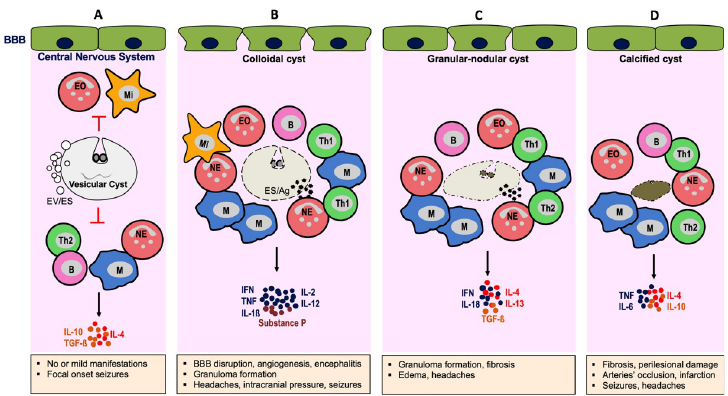
Fig 2. Cyst involution in brain parenchyma and associated immunopathogenesis. The presence of viable vesicular cysts (A) is usually asymptomatic and associated with suppression of the host immune responses through induction of anti-inflammatory cytokines. Upon successful attack of the host immune system, the cyst passes through a series of involuting stages (B–D). The BBB is disrupted, and granuloma, mainly composed of macrophages, granulocytes, and lymphocytes, encompasses the cyst that contracts (colloidal stage) (B) and becomes nodular and the scolex granulated (granular-nodular stage) (C); this is followed by the formation of collagenous and fibrotic structures and calcification of the cyst (calcified stage) (D). Each involuting stage of the cyst releases material (ES and Ag) and elicits an inflammatory reaction and release of mediators in the brain that lead to the development of pathology and symptoms (pale orange box). Ag, cyst antigen; B, lymphocyte B; BBB, blood–brain barrier; EO, eosinophil; ES, excretory– secretory; EV, extracellular vesicle; IFN, interferon; IL, interleukin; M, macrophage; Mi, microglia/dendritic cell; NE, neutrophil; TGF-ß, transforming growth factor beta; Th, T helper cell; TNF, tumor necrosis factor.